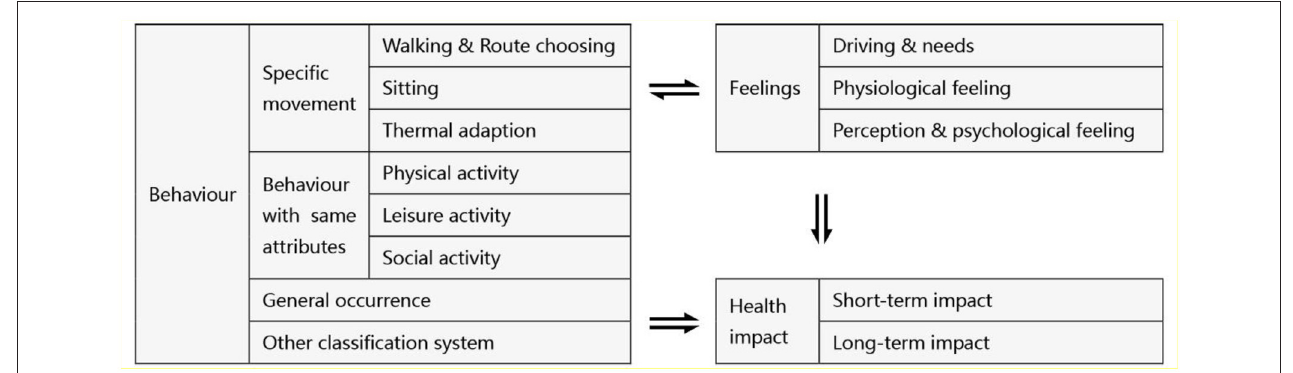
FIGURE 1 | Subjective feedbacks frequently investigated in public open